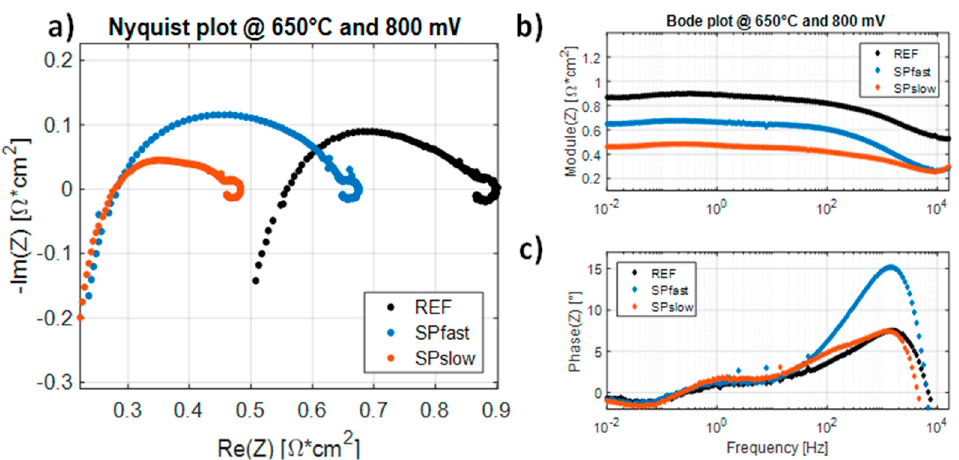
Figure 12. Nyquist ( a ) and Bode ( b , c ) plots of samples REF (black markers), SPfast (blue markers), and SPslow (red markers) measured at 650 °C and 800 mV.